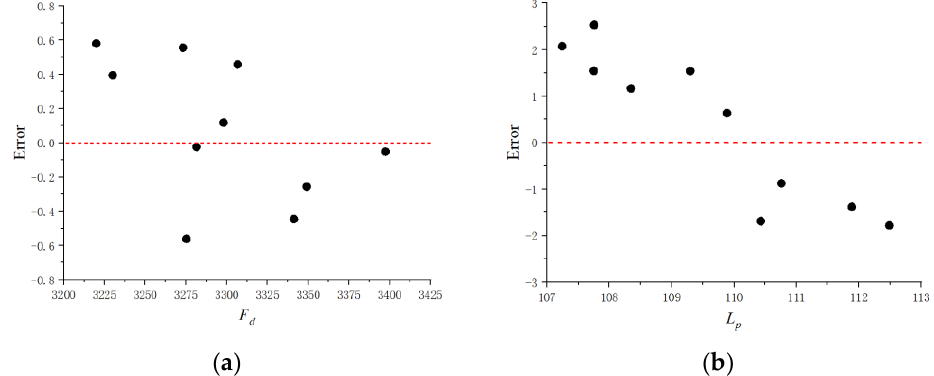
Figure 6. Error between predicted value and actual value of output variables: ( a ) Percentage of aerodynamic resistance, ( b ) Difference of dipole noise source.